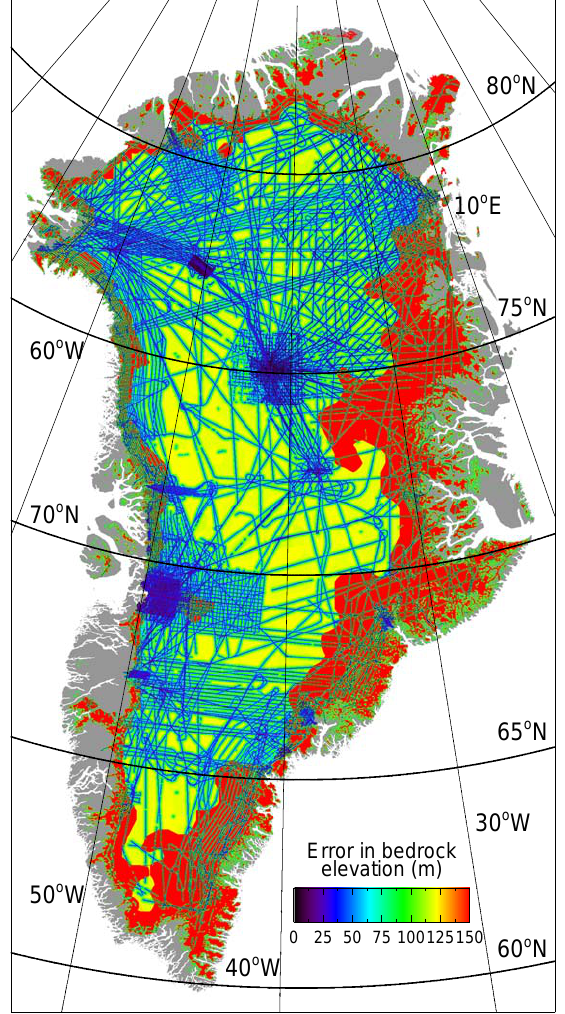
Fig. 7. RMS error in bed elevation due to the combined uncertainties in the IPR data and those due to